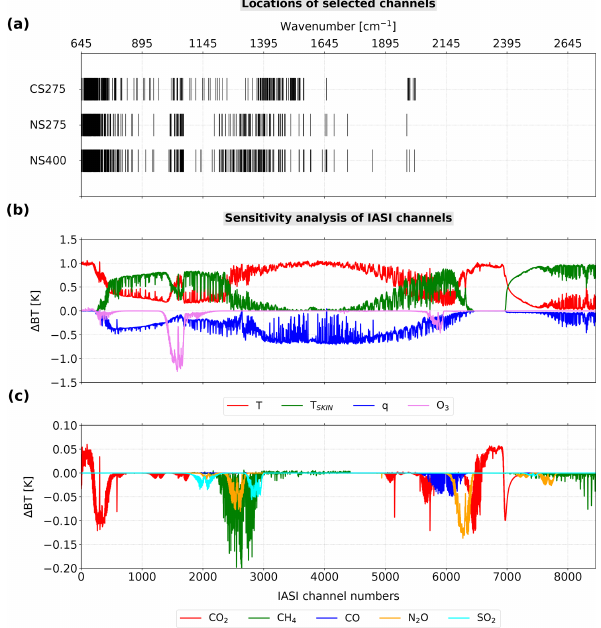
Figure A1. Location of CS275, NS275 and NS400 IASI channel selections (a) . Sensitivity analysis of IASI channels to temperature, skin temperature, humidity and ozone (b) . Sensitivity analysis of IASI channels to carbon dioxide, methane, carbon monoxide, ni- trous oxide and sulfur dioxide (c) .